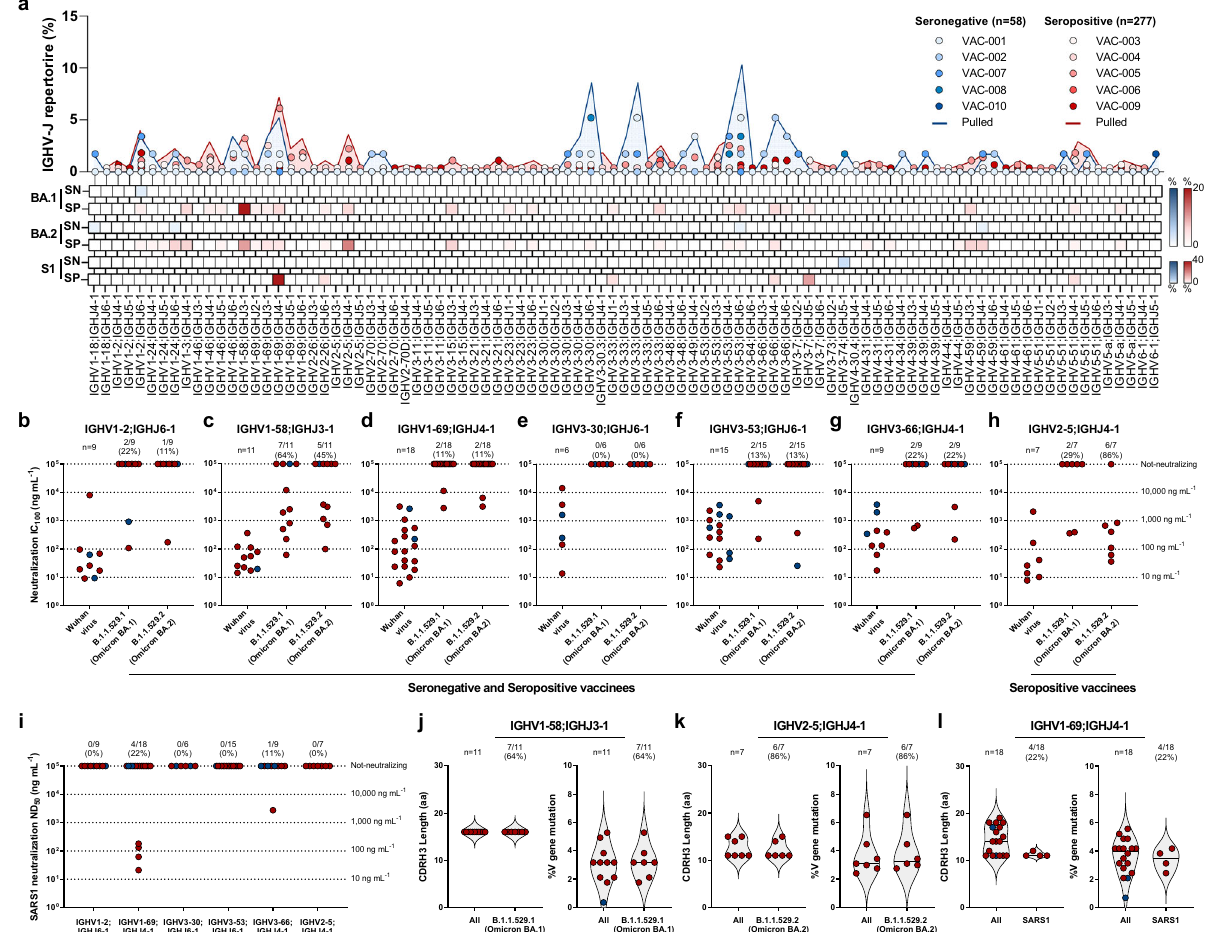
Fig. 3 Genetic characterization of BA.1, BA.2, and SARS1 nAbs. a The graph shows the IGHV-J rearrangement frequencies between vaccinees who were seronegative (SN) and seropositive (SP) (top), and the frequency within BA.1 (top heatmap), BA.2 (middle heatmap), and SARS1 (S1) (bottom heatmap) nAbs. b – h The graphs show the neutralization potency (IC 100 ) of IGHV1-2;IGHJ6-1 ( b ), IGHV1 – 58;IGHJ3-1 ( c ), IGHV1 – 69;IGHJ4-1 ( d ), IGHV3 – 30;IGHJ6-1 ( e ), IGHV3 – 53;IGHJ6-1 ( f ), IGHV3 – 66;IGHJ4-1 ( g ) and IGHV2 – 5;IGHJ4-1 ( h ) gene-derived nAbs, against the original SARS-CoV-2 virus fi rst detected in Wuhan and the BA.1 and BA.2 VoCs. i The graph shows the neutralization potency (ND 50 ) of predominant germlines against SARS1. j – l Violin plots show differences in the aminoacidic (aa) CDRH3 length and percentage of V gene somatic mutations for all IGHV1 – 58;IGHJ3-1 ( j ) IGHV2 – 5;IGHJ4-1 ( k ) and IGHV1 – 69;IGHJ4-1 ( l ) antibodies compared to BA.1, BA.2, and SARS1 nAbs